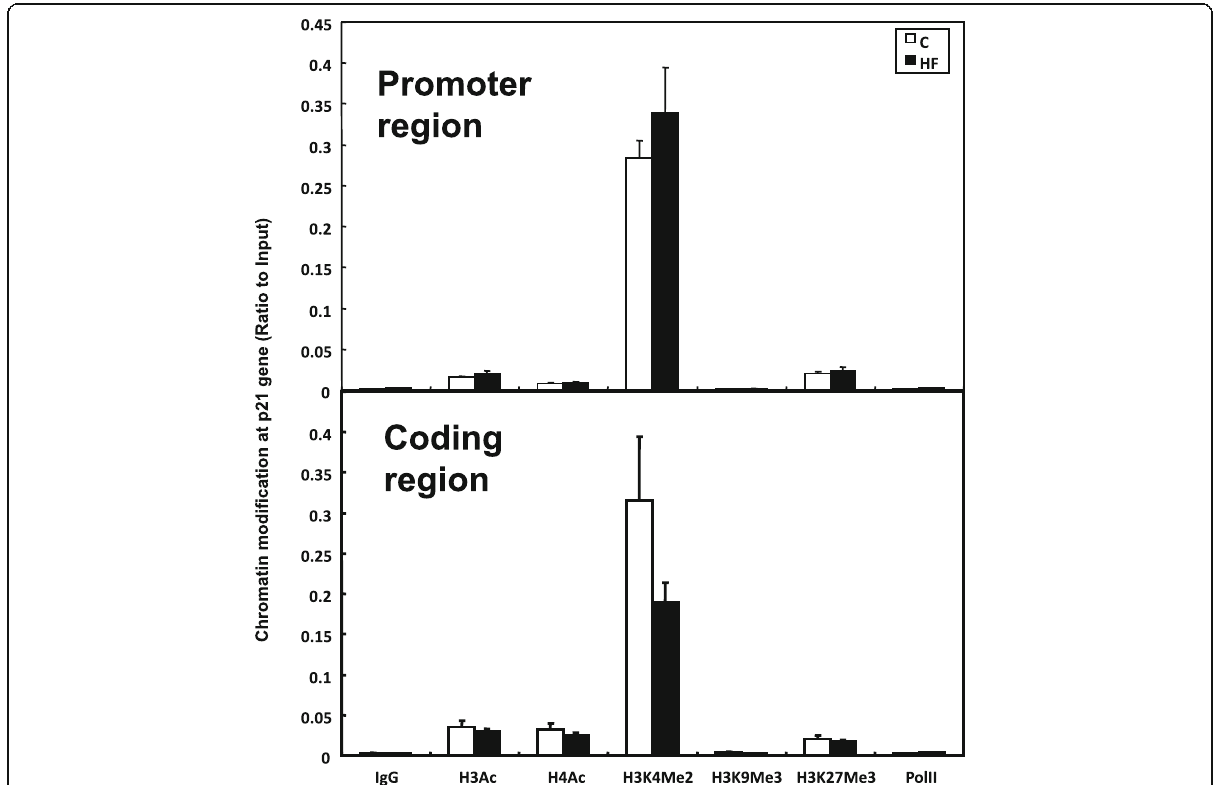
Fig. 6 Chromatin modification at coding region and promoter region in p21(Cip1) gene in livers of rats fed C and HF diets respectively. Chromatin status in p21(Cip1) gene at different regions in HF and C rats as determined by ChIP assay. Data are presented in arbitrary units as relative DNA abundance normalized to DNA of input abundance. Values are means ±